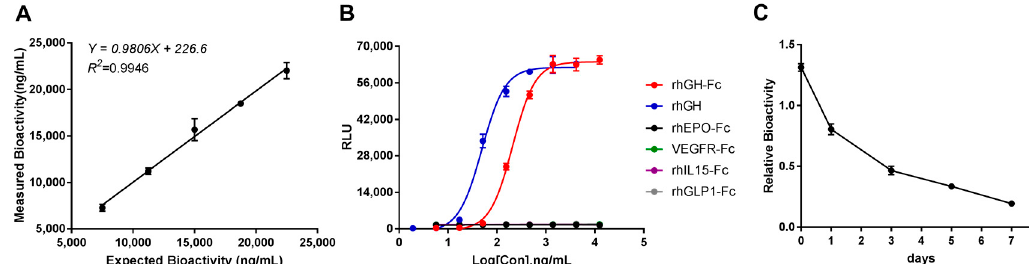
Figure 3. The validation of linearity and specificity. ( A ) A linearity plot of the expected bioactivity against the measured bioactivity. ( B ) The specificity of the bioassay to rhGH-Fc, rhGH, and other therapeutic Fc-fusion proteins. ( C ) The specificity of the bioassay to the thermal degradation of rhGH-Fc. The representative linearity plots of three independent experiments are shown.